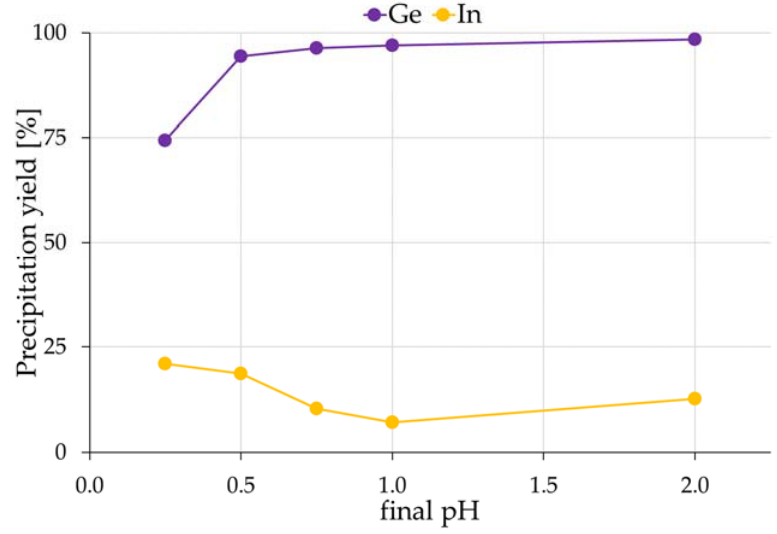
Figure 6. Influence of Zn final pH on precipitation yields of Ge and In (75 °C, 2 h, detinned solution, 100 g/dm 3 zinc dust added).